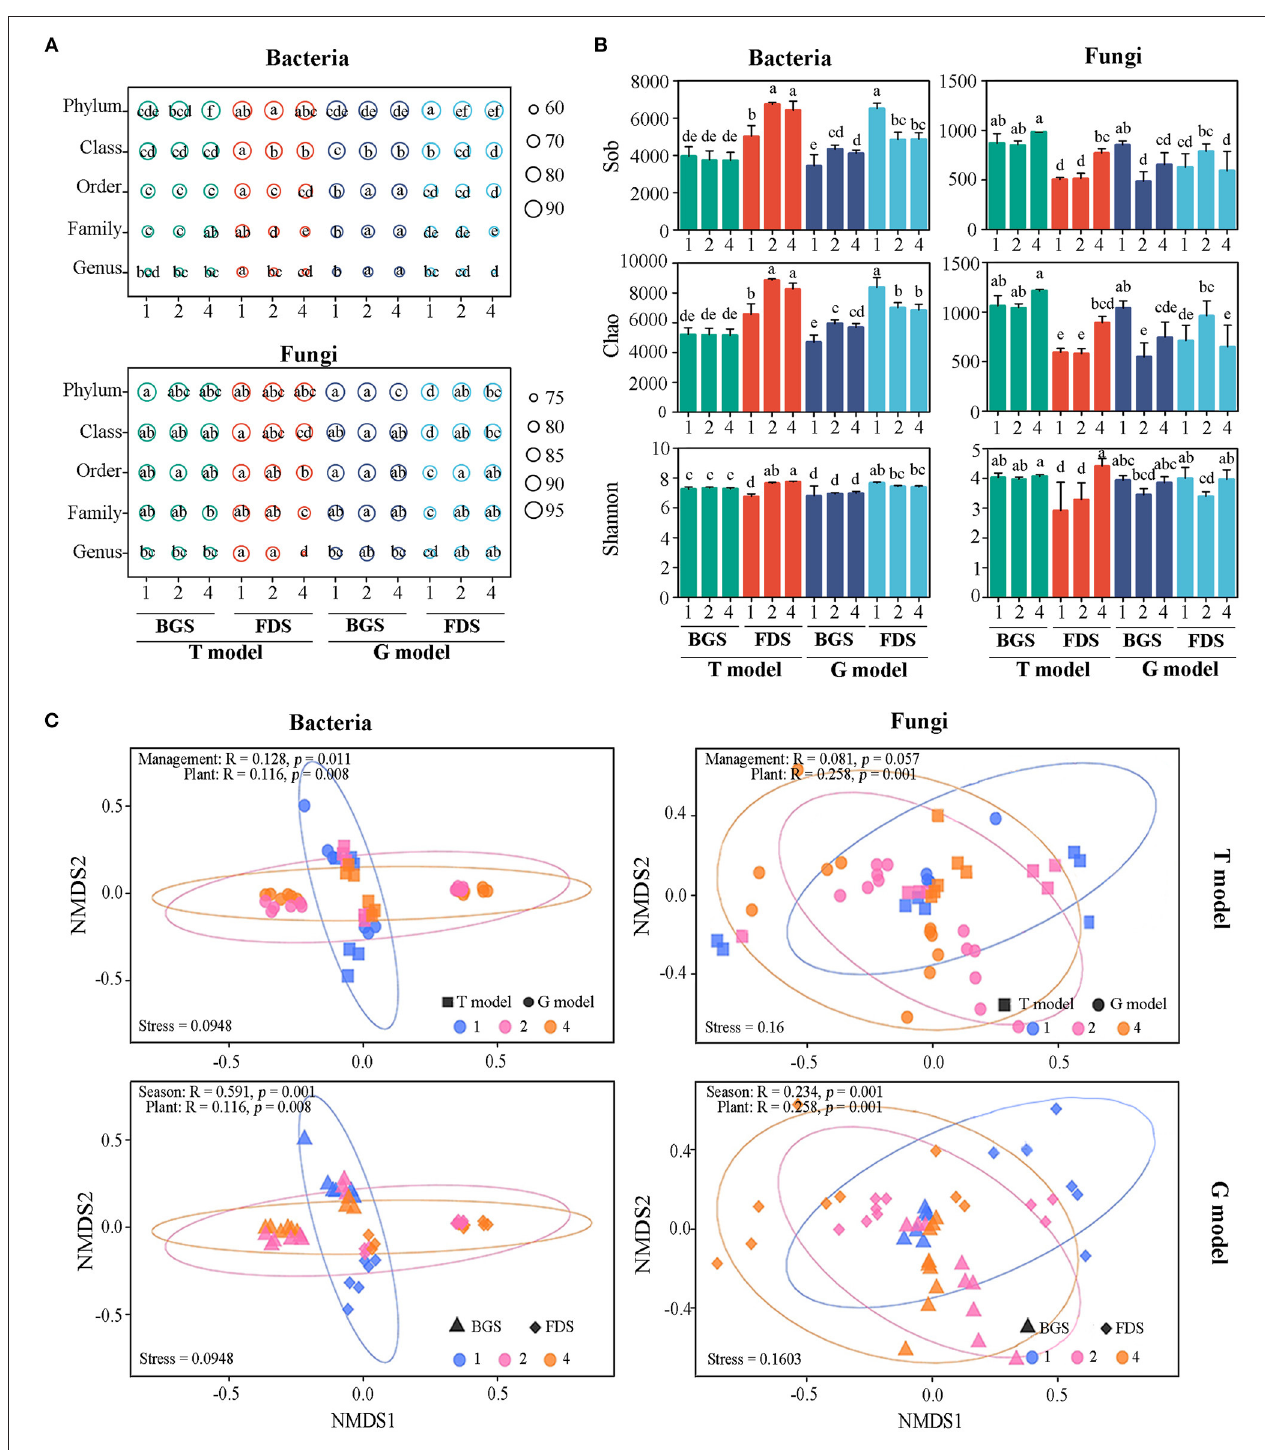
FIGURE 2 | Variation in the structure, alpha diversity and beta diversity of soil microbial communities between the intercropping patterns and the development stages. (A) The percentage of the total microbial community at the taxon level for the bacterial and fungal communities. (B) Alpha diversity of bacterial and fungal communities. Sob was the observed operational taxonomic units (OTUs); Chao was used to evaluate community richness based on OTUs; and the Shannon index was used to assess community diversity. (C) Beta diversity of bacterial and fungal communities. NMDS shows the structures of the soil bacterial and fungal communities. Ninety-five percent confidence ellipses are shown around the samples grouped based on intercropping soil. Similarity values, which are shown in each plot, among the samples of plant species richness of IAP between the intercropping patterns and development stages were examined via ANOSIM. 1, 2, and 4 indicate intercropping with 0, 1, and 3 species of aromatic plants, respectively, to facilitate regression analysis. BGS, branch growth stage; FDS, fruit development stage. T model, intercropping with aromatic plants in the clean tillage soil; G model, intercropping with aromatic plants in the natural grass soil. Different letters indicate significant differences at P < 0.05 based on Duncan’s multiple range